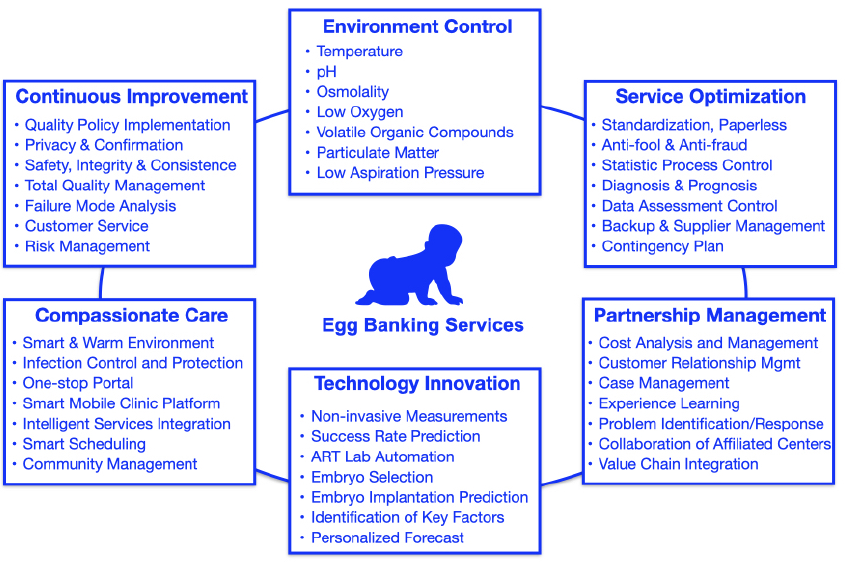
Figure 2. Activities, operations and functions for successful egg banking